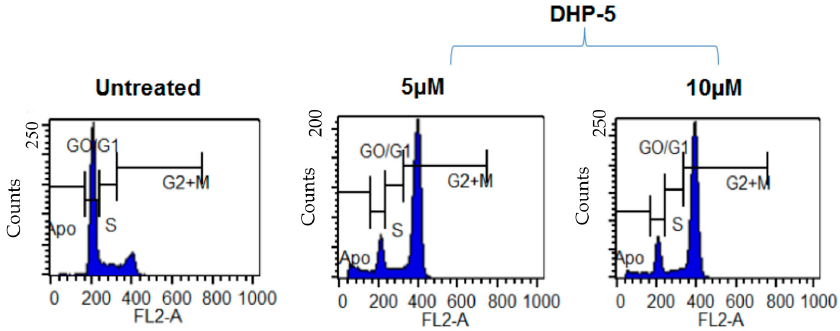
Figure 4. Compound DHP-5 arrested cancer cells at G2 checkpoint.